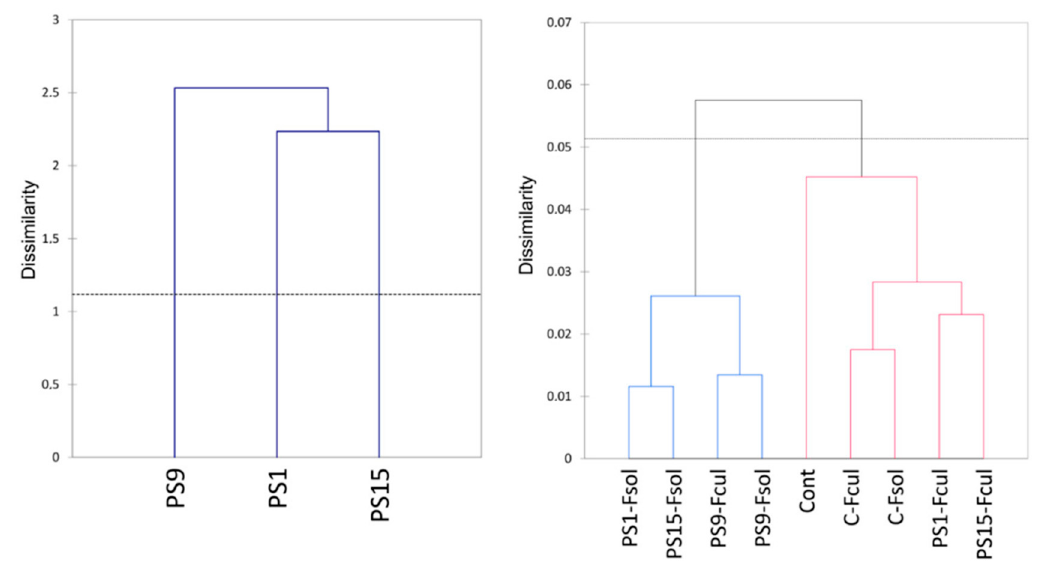
Figure 4. Agglomerative hierarchical clustering indicating, on the right: enzymatic differences between PGPB strains (calculation based on results from Table 2); on the left: differences between variants used in pot tests (calculation based on results from Table 3). Abbreviations: Cont, C—control without the use of microorganisms; Fcul— F. culmorum ; Fsol— F. solani; PS1, PS9, PS15—PGPB